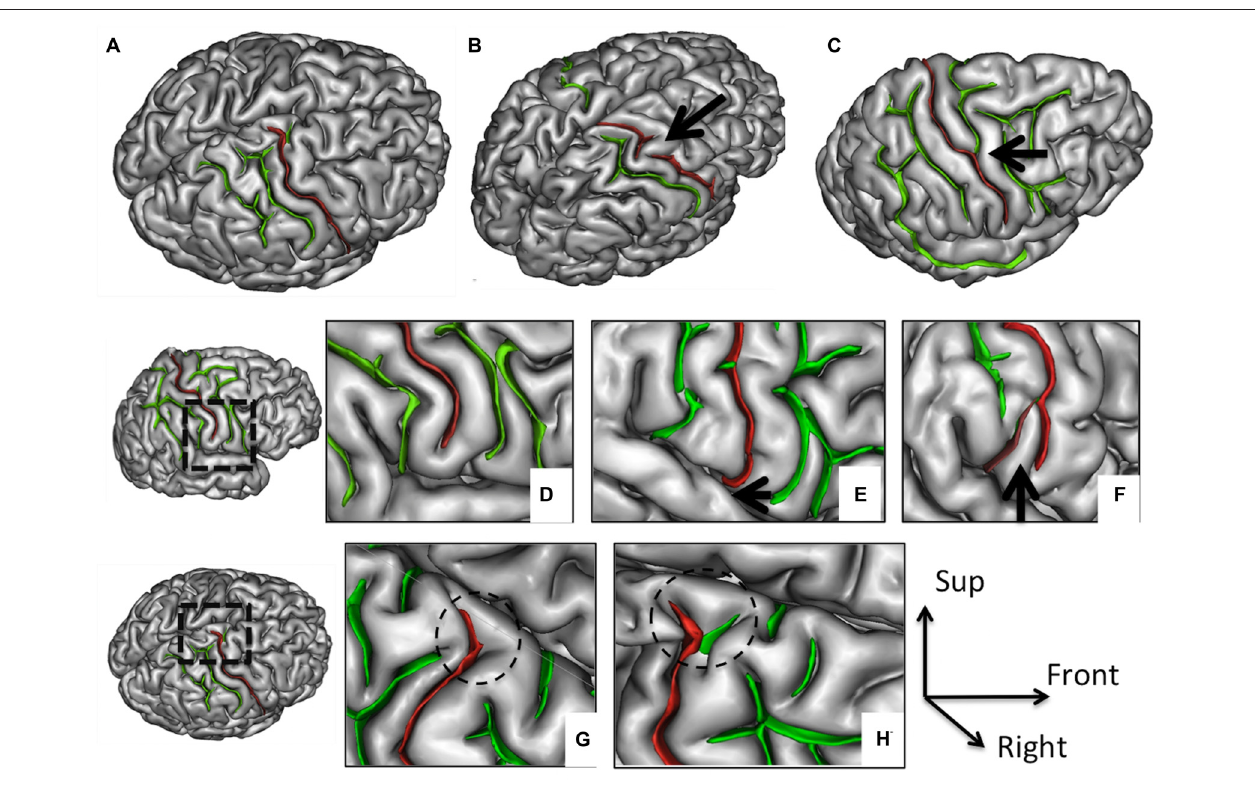
FIGURE 1 | Morphological features of the central sulcus (CS) with an excellent inter-rater concordance ( κ > 0.80) and with values (frequency occurrence) that did not differ from Ono’s post-mortem values. The CS (in red) is represented on a three dimensional (3D) mesh-based reconstruction of the cortex surface. Continuous (A) or interrupted ( B , arrow) CS. Connection with the precentral sulcus (PreCS; C , arrow). Inferior end without (D) or with extension to the sylvian fissure (SF; E , arrow). Inferior end “Y” shape (F) . Superior end: “T” shape (G) or “Y” shape (H)